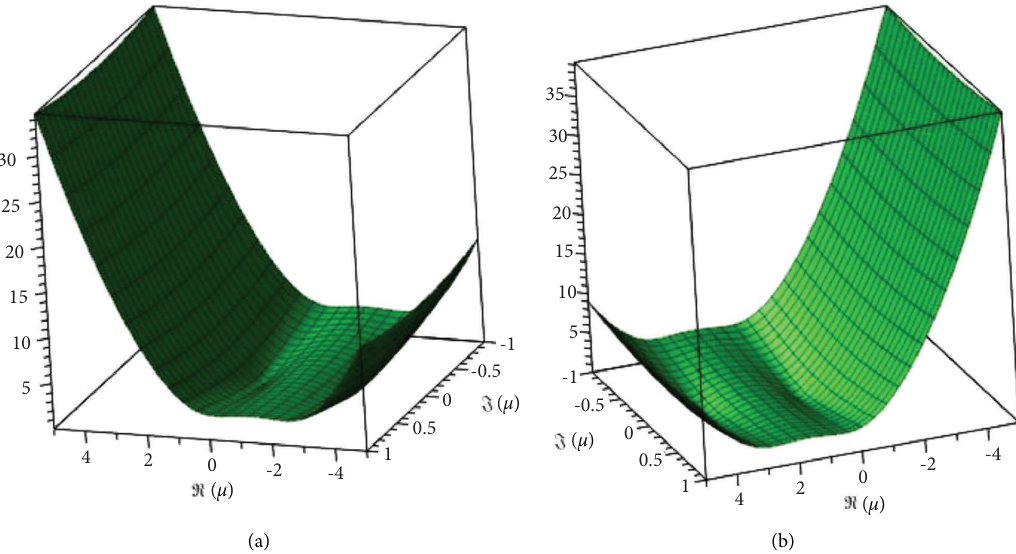
Figure 10: For varying Z and η values, the recovered cases are slightly decreasing and then increasing slowly (a) G